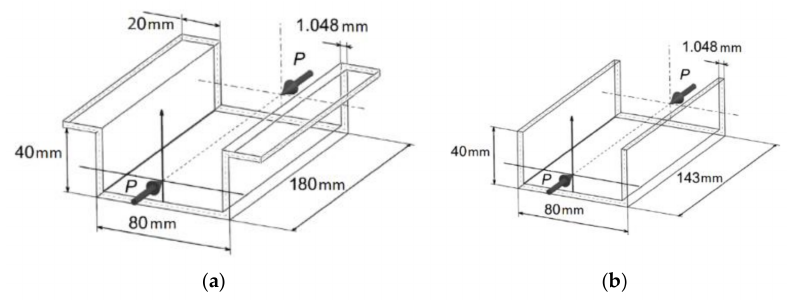
Figure 1. Geometrical parameters of specimens with layers arrangement: ( a ) top-hat; ( b )